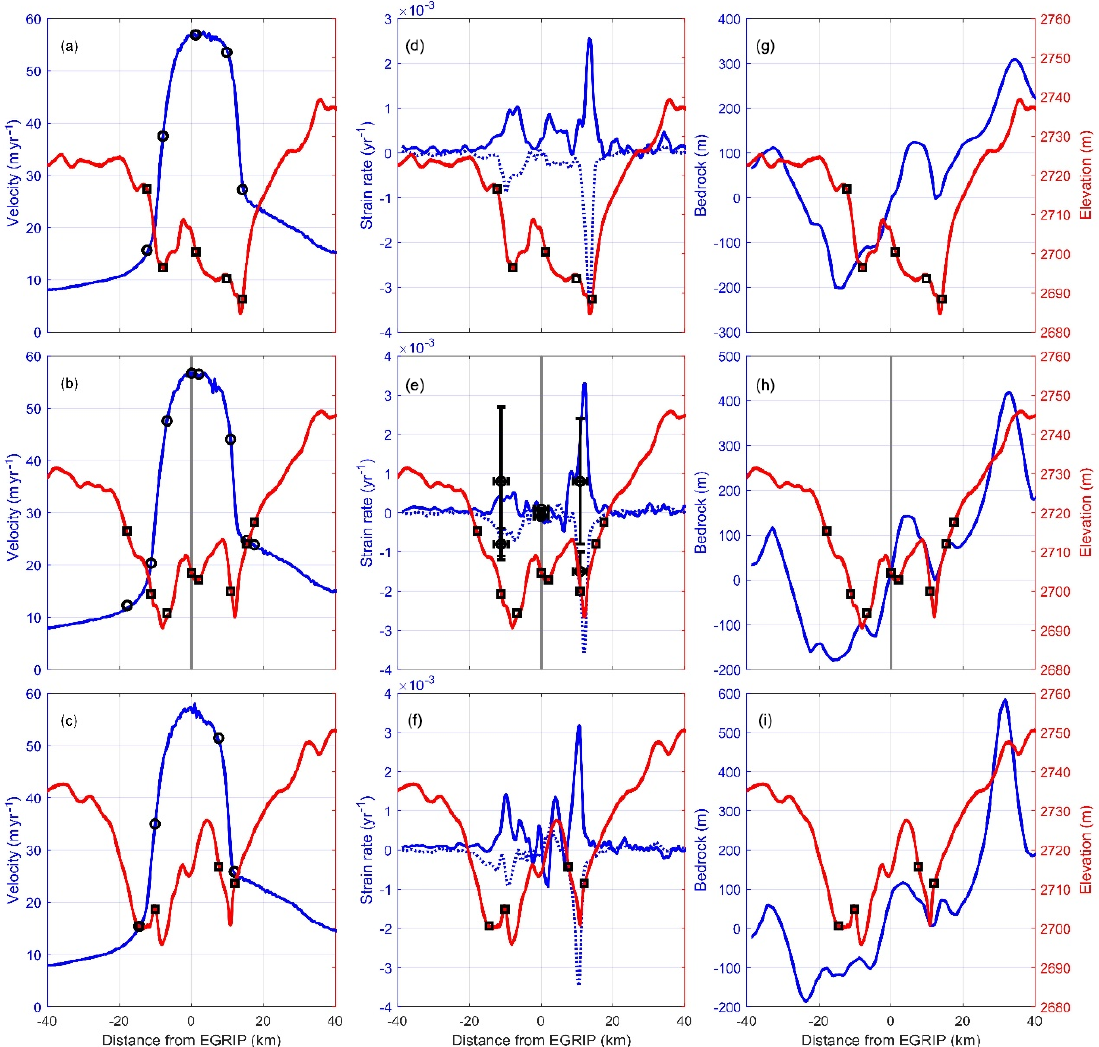
Figure 3. Ice flow and surface elevations of three cross sections of NEGIS separated by 2.5km: (a, d, g) downstream from the EastGRIP site, (b, e, h) at the EastGRIP site, and (c, f, i) upstream from the EastGRIP site (the cross sections are indicated in Fig. 2b). (a, b, c) Surface velocity (blue) and surface elevation (red). (d, e, f) Surface strain rates relative to the local flow direction, along flow (solid blue) and transverse to flow (dotted blue) with positive for stretching and negative for compression, and surface elevation (red). (g, h, i) Surface elevation (red) and bedrock topography (blue). GPS observations are shown as black circles or squares at three stakes marked in Fig. 5. Surface elevation is from ArcticDEM (Porter et al., 2018); surface velocity and strain rate profiles are derived from the MEaSUREs Multi- year Greenland Ice Sheet Velocity v1 product (Joughin et al., 2016, 2018a); and the bedrock topography is from BedMachine v3 (Morlighem et al., 2017a, b). The vertical gray lines in (b, e, h) indicate the position of the central stake near the EastGRIP